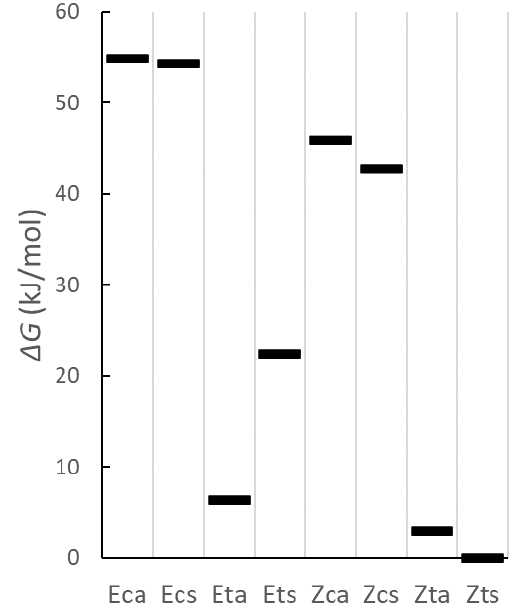
Figure 7. Relative free energy at 298 K of the minimum energy structures of 1 calculated at the ω B97M-D4/cc-pVTZ level. The vertical lines are just a guide for the eye.